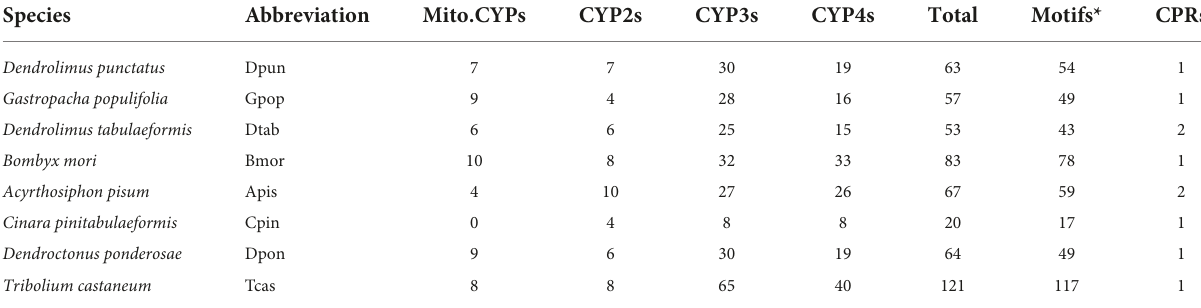
TABLE 2 Number of subfamilies of P450 genes in nine insects ( > 300AA).